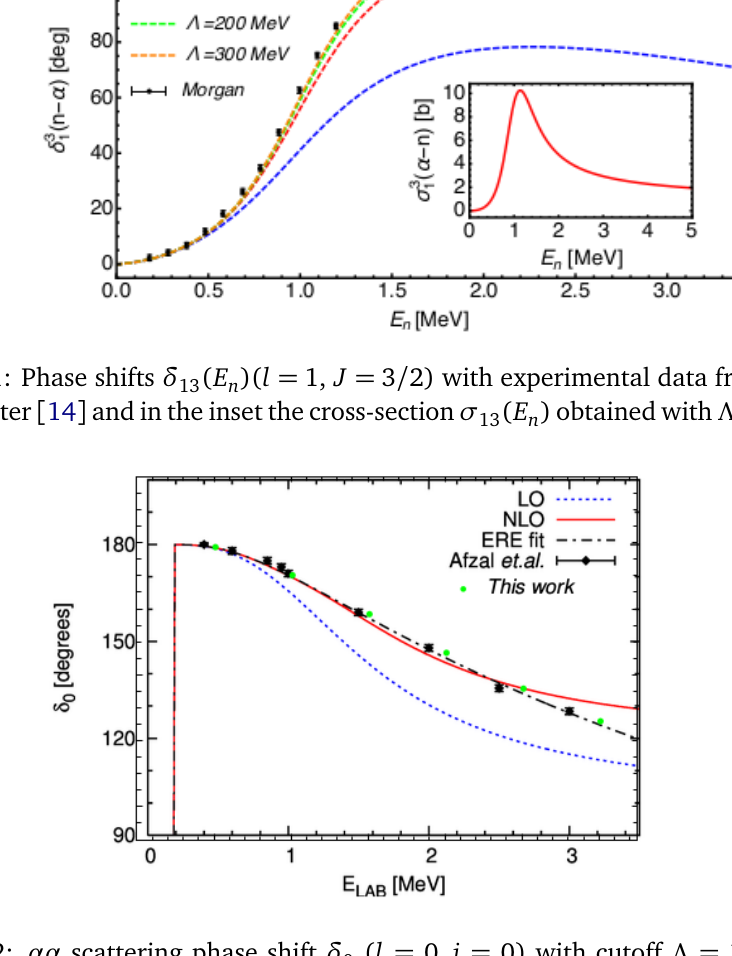
Figure 2: αα scattering phase shift δ ( l = 0, j = 0) with cutoff Λ = 100 MeV in 0 comparison with experimental data from Azfal et al. [ 15 ] and with another Halo EFT calculation [ 7 ] in lowest order (LO) and Next-to-leading order (NLO). Also shown their fit using the effective range expansion formula (ERE